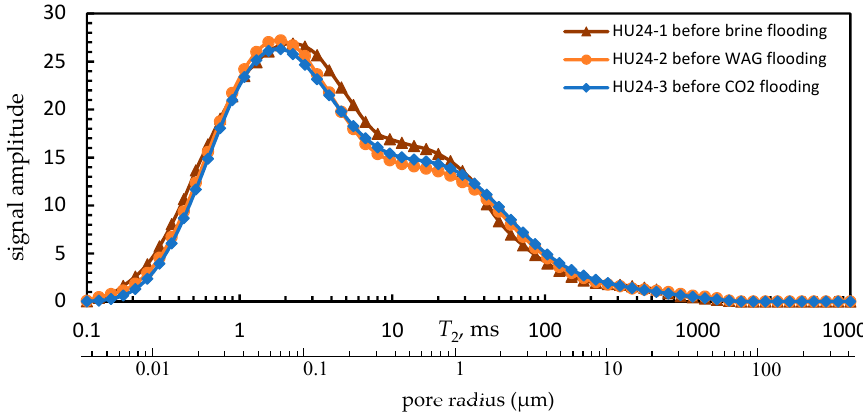
Figure 2. Nuclear magnetic resonance (NMR) T 2 spectrum of the three cores before experiments.